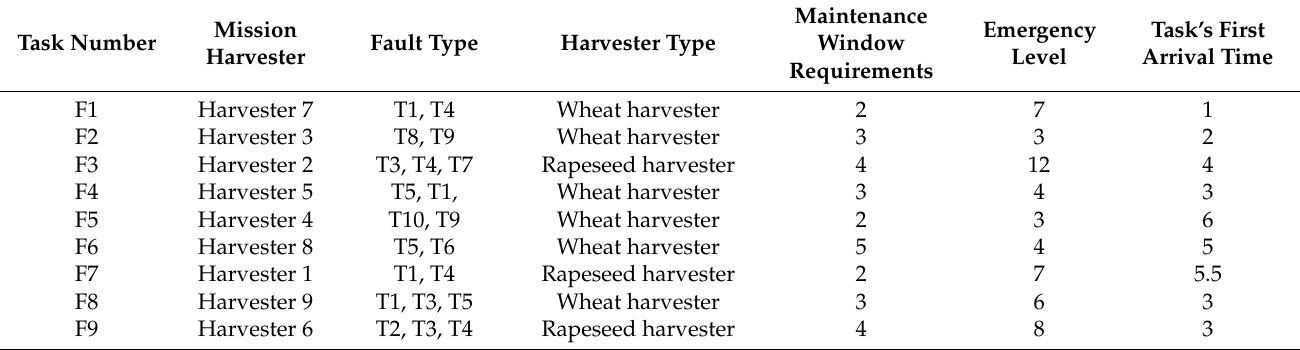
Table 4. A day’s task and maintenance demand information table.